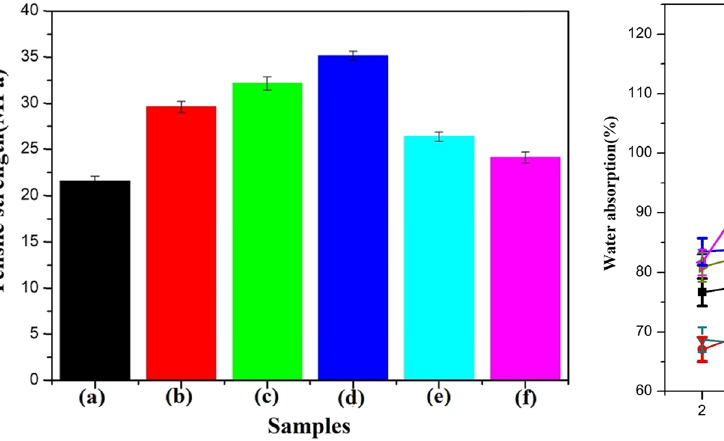
Figure 5: Water absorption of the composite membranes during the soaking.